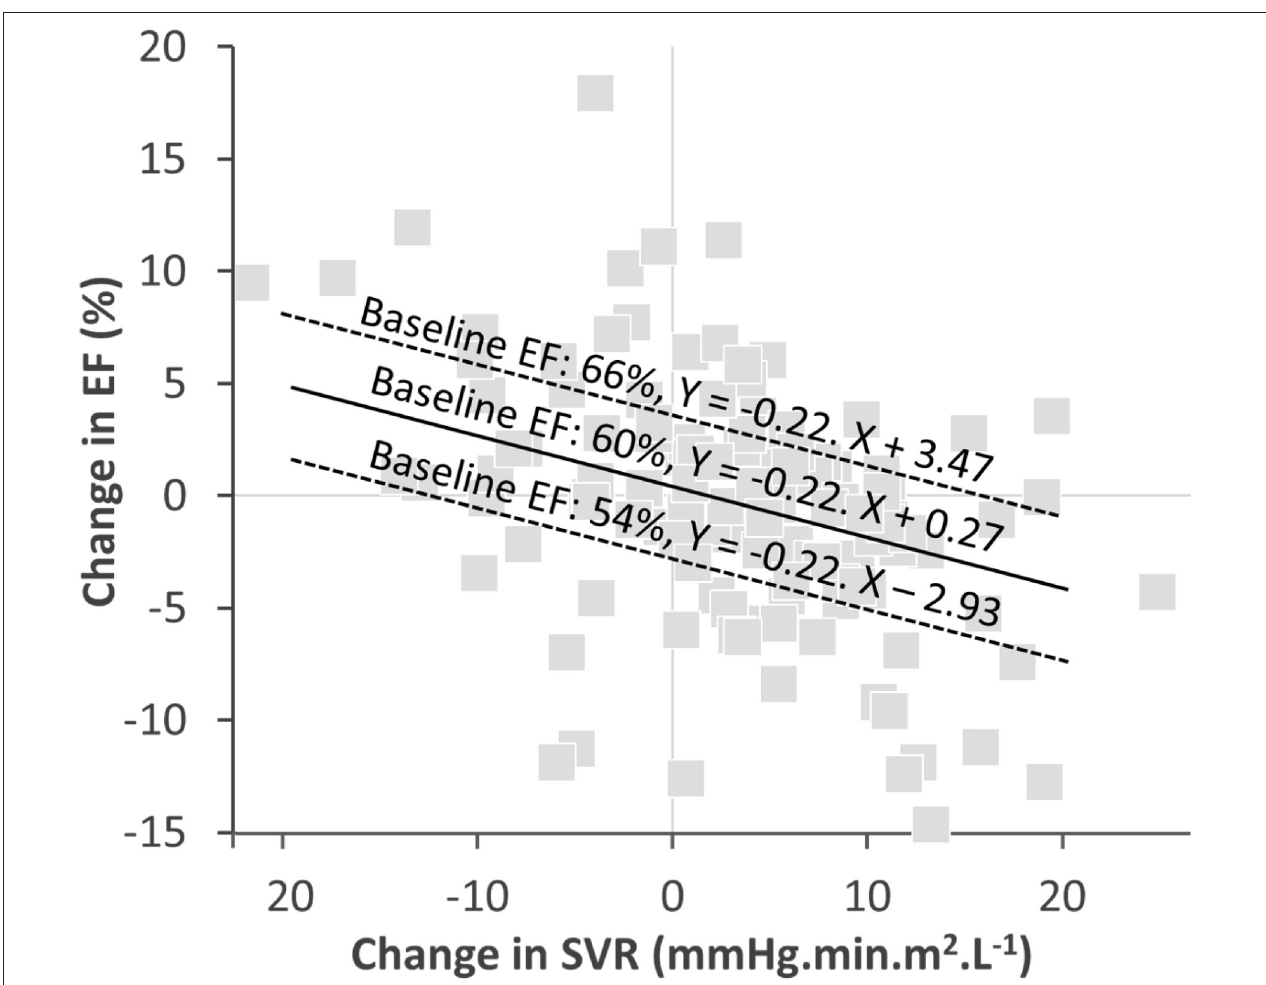
FIGURE 3 | Graph of the correlation between EF-changes and SVR-changes with the regressions computed with the equation from Table 3 for three baseline EF levels: close to the mean (60%), one SD above the mean (66%), and one SD below the mean (54%). The slope of EF- and SVR-changes for the 3 baseline FE levels are identical. However, the intercept corresponding to an absence of any SVR variation are different, with a predicted absolute decrease in EF of ∼ 3% for the 66% EF baseline, an increase of about 3% for the 54% EF baseline and an insignificant predicted change for the 60% EF baseline.